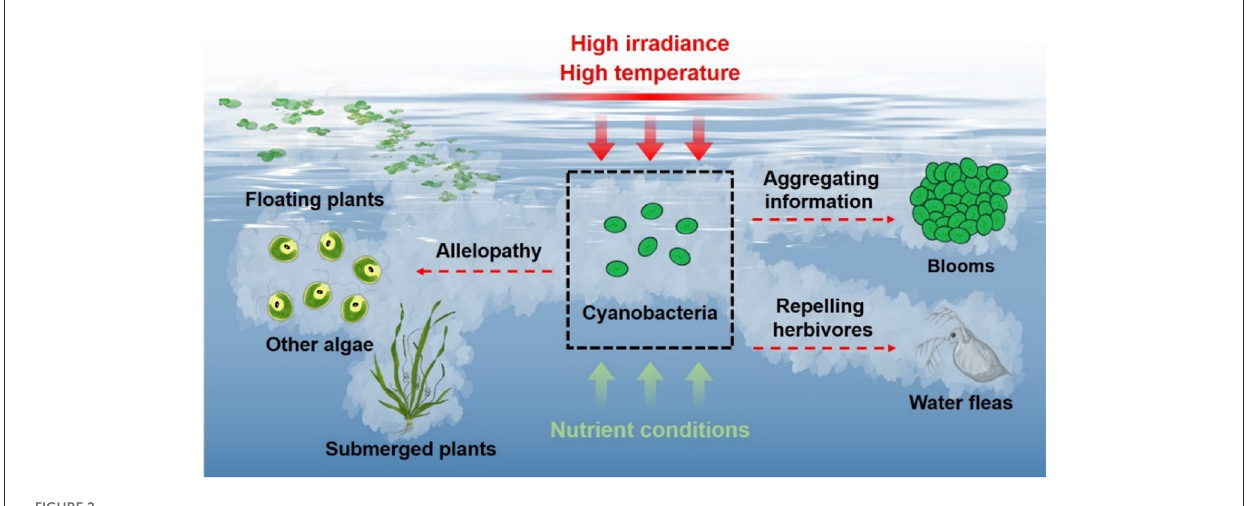
FIGURE2 Emission of cyanobacterial VOCs and their roles.